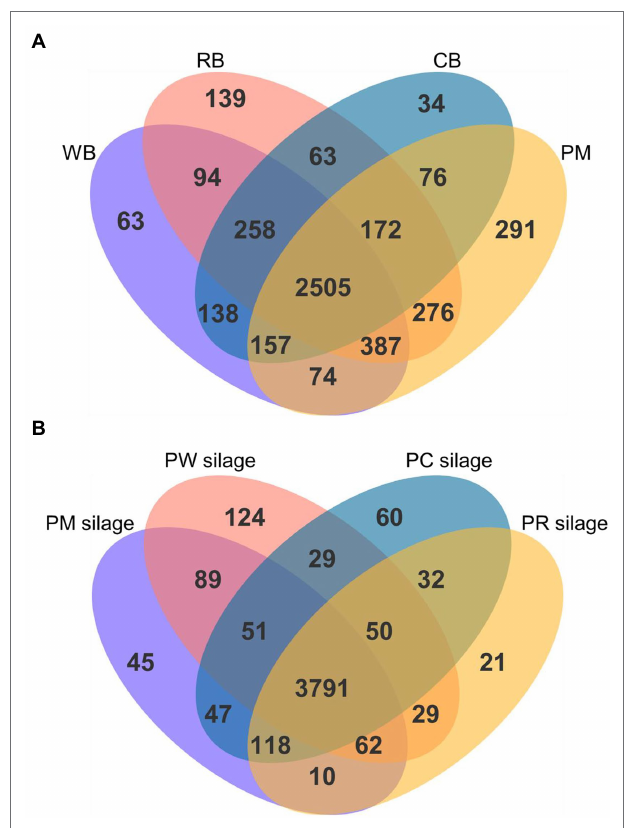
FIGURE 2 | Venn diagram of all the metabolites identified in the PM, CB, RB, WB material (A) , and their silage (B) . PM, paper mulberry; CB, corn bran; RB, rice bran; WB, wheat bran; PC, PM + CB; PR, PM + RB; PW, PM +